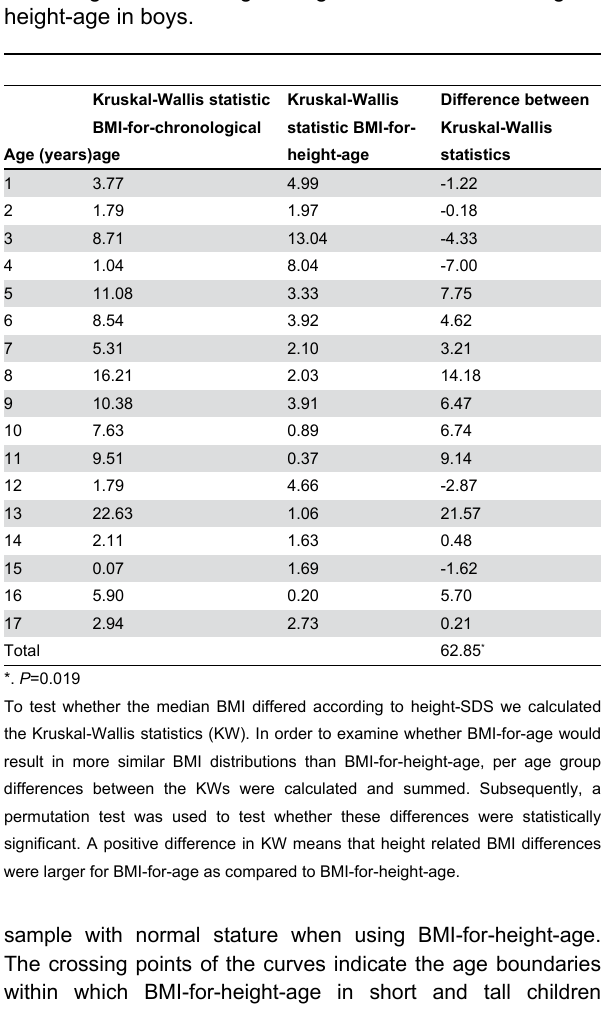
Table 3. Differences in Kruskal-Wallis statistics to identify intergroup differences between the samples for BMI according to chronological age and BMI according to height-age in